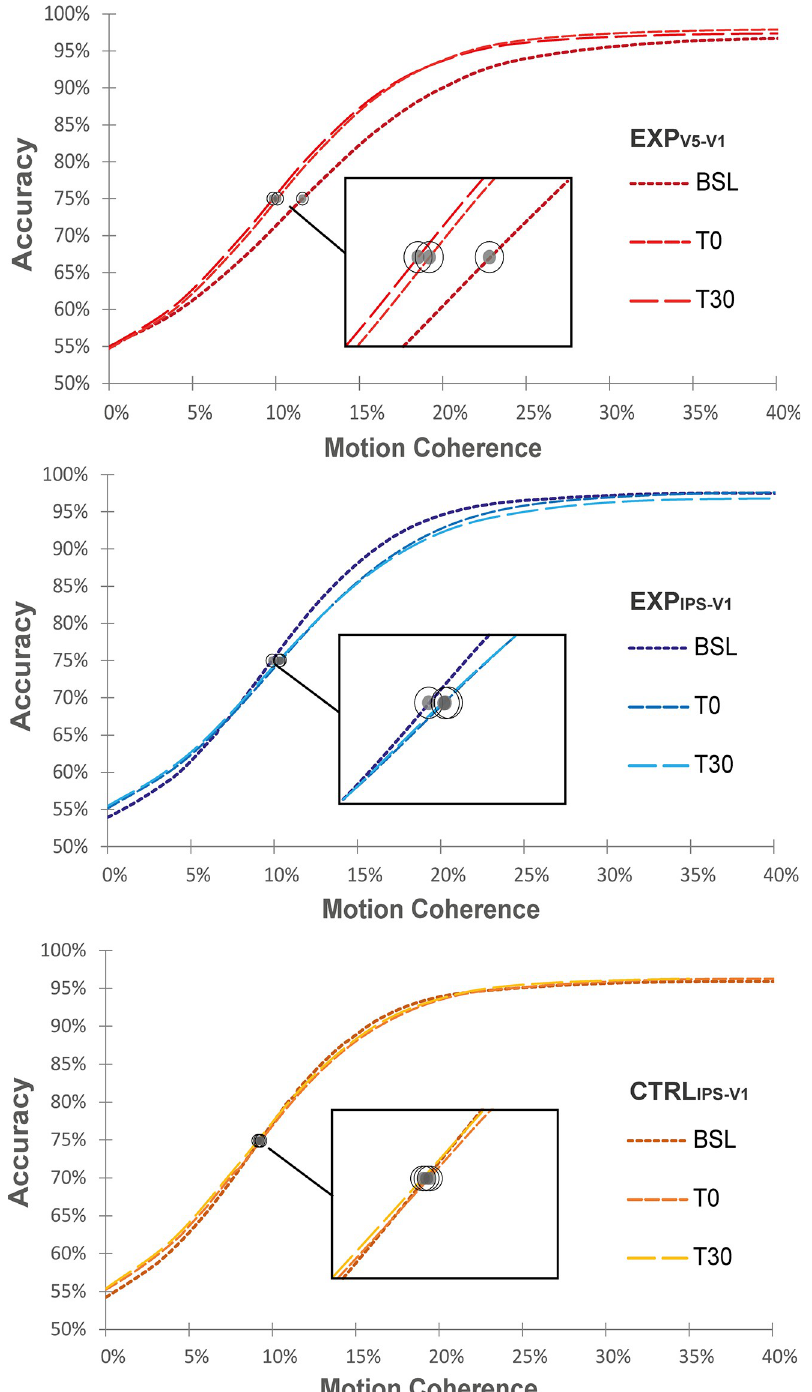
Fig 2. Psychometric curves. Fitted data modeled on the logistic function to obtain the perceptual thresholds of motion discrimination. Group performance are separately plotted depending on the type of stimulation (top graph, in red Exp V5-V1 ; mid graph, in blue Exp IPS-V1 ; bottom graph, in yellow Ctrl IPS-V1 ) and as a function of the session. Gray dots depict the perceptual threshold coincident with the percentage of coherent motion where the logistic function had a value of 75% of correct responses. Perceptual thresholds shifts on the abscissa represent lower (right-shift) or higher (left-shift) motion sensitivity. Data underlying this figure can be found in OSF: https://osf.io/x7d2e/?view_only= ac2ff19b1ab6415cb471895854fb5a35.